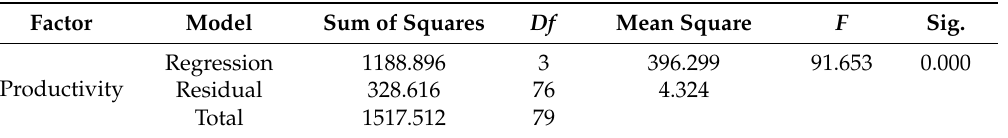
Table 7. Results of the analysis of variance on the productivity.